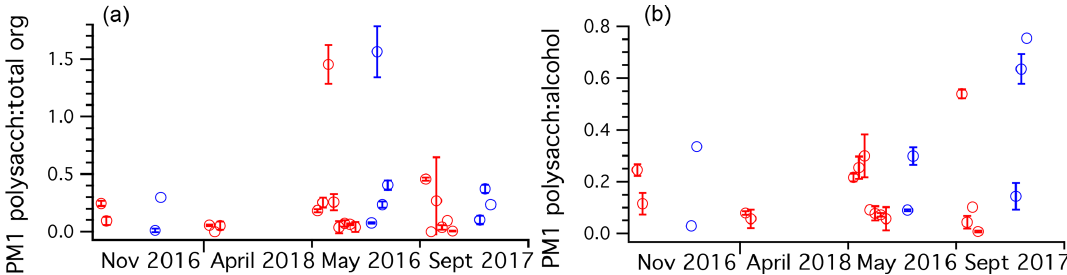
Figure 6. Ratio plots of (a) TDCIMS polysaccharide to FTIR total organics and (b) TDCIMS polysaccharide mass to FTIR alcohol group mass ratios for PM1 aerosol filter samples taken over the four NAAMES cruises, organized by season. Any negative (below background) signals were removed from the analysis. One-standard-deviation error bars are plotted for samples with replicate runs on